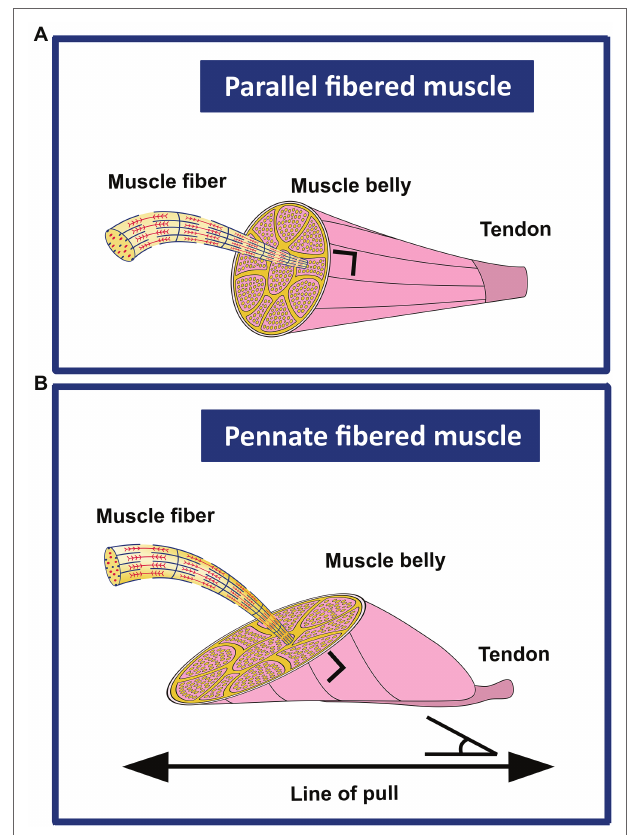
FIGURE 4 | Schematic representation of the contribution of sarcomeres (serial and in parallel) to the muscle belly length, as well as PCSA in parallel and uni-pennate fibered muscles. (A) In parallel fibered muscles, the length of the muscle belly is determined by the number of sarcomeres in series, as well as the slack, optimum length and the length range of active force exertion, whereas sarcomeres arranged in parallel determine the (fiber) CSA. (B) In pennate fibered muscles, the muscle belly length is determined both by sarcomeres in series, as well as by the number of sarcomeres in parallel. The number of sarcomeres in parallel also determines the (fiber) CSA. This latter is described as the area of the transversal section perpendicular to the muscle fiber direction. In pennate muscles, the PCSA contributes to the optimum length and range of active force exertion. When muscle fibers that are under a line of pull generate force, the contribution to the muscle length is less than that of the muscle fiber length